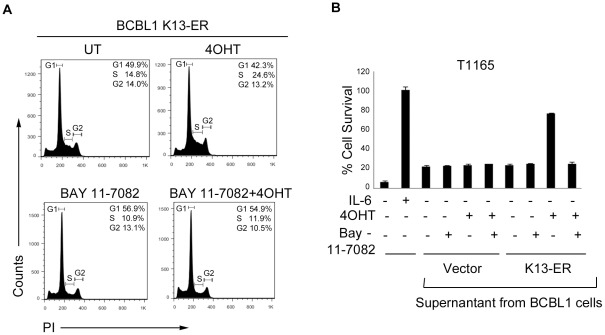
Biological assays to study K13-induced IL6 production and cell cycle analyses.(A) A DNA content analysis showing significant increase in S-phase of cell cycle by 4OHT treatment in serum-starved BCBL1 K13-ERTAM cells and inhibition of this increase in S-phase cells by pre-treatment with Bay-11-7082 (2 µM). DNA content analysis was performed as described previously [7] and explained in Materials and Method section. (B) Cell survival of T1165 cells with supernatants from 4OHT-treated BCBL1-K13-ERTAM cells. BCBL1 vector- and K13-ERTAM cells were pretreated with 2 µM Bay-11-7082 for 2 hours followed by treatment with 4OHT for additional 72 hours and supernatants from these cells were collected and filtered. T1165 cells were treated in triplicate in a 96 well plate (100 µl/well) with 20 µl of cell-free supernatant collected from cells described above. Seventy-two hours post-treatment, cell viability of T1165 cells was measured by MTS assay as described in Materials and Method section. The values (Mean±SEM) shown are from a representative of three independent experiments performed in triplicate.